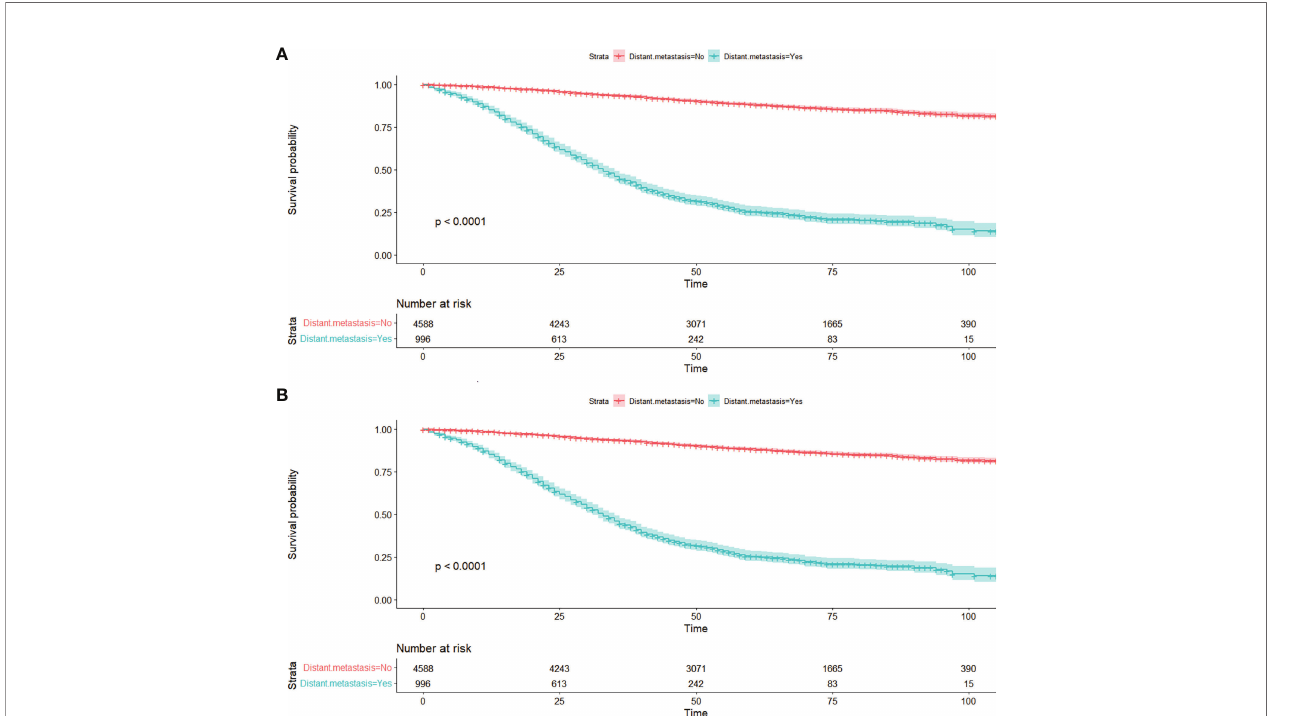
FIGURE 2 | Kaplan-Meier curves of distant metastasis for OS (A) and CSS (B) in all patients from SEER database. OS, overall survival; CSS, cancer-speci fi c survival; SEER, Surveillance, Epidemiology, and End Results